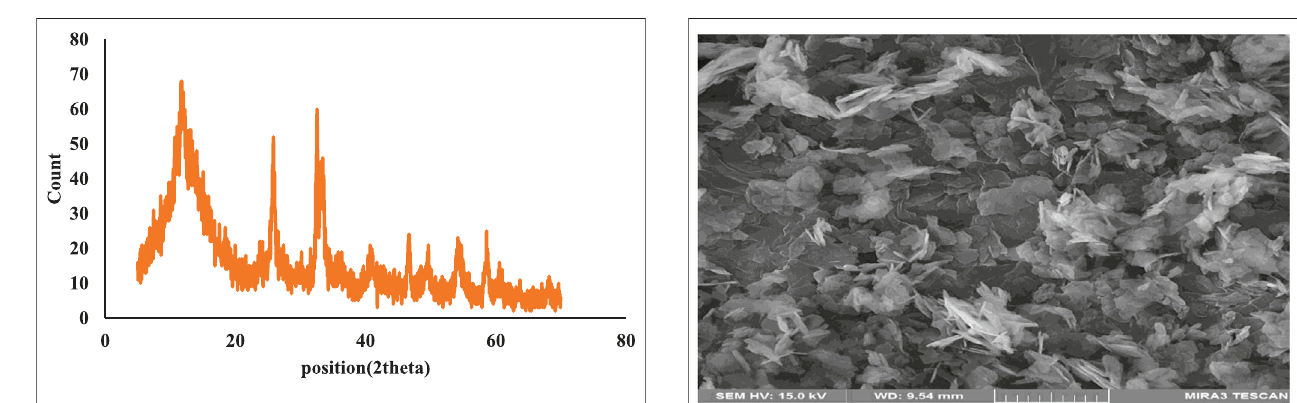
FIGURE 2 | XRD patterns of Y-MOF synthesized under the optimal condition of the microwave route.